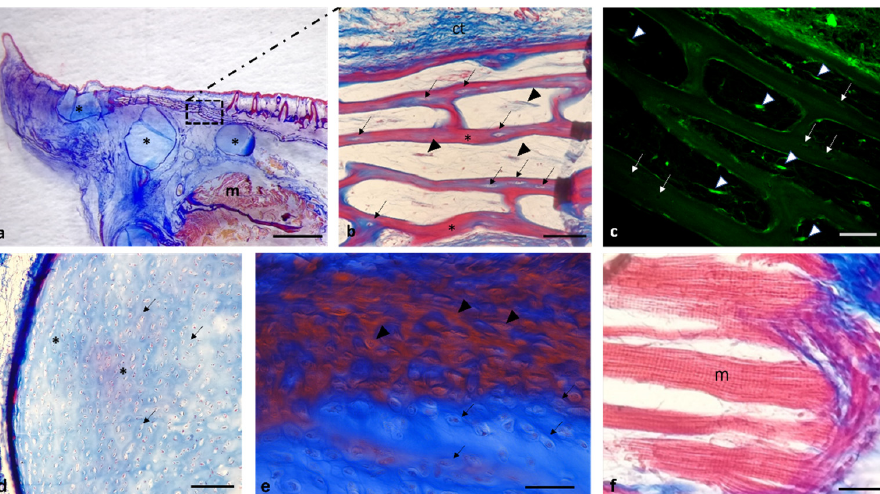
Figure 5. Masson Trichrome with Aniline Blue staining. ( a ) Stereomicrograph of a sagittal section of the tongue: tongue dorsal surface (arrows) covered by several papillae. ( b ) Light micrograph of tongue apex, corresponding to insert b: stratified epithelium with abundant caliciform cells (arrows), basal membrane (asterisk) connecting the epithelium and loose connective tissue (lct). ( c ) Mucosa of the tongue body raising in folds and showing taste buds (arrowhead), basal membrane (asterisk), dense connective tissue (dct) projecting at taste bud base; loose connective tissue (lct) in deeper layers. ( d ) Light micrograph of tongue root: villiform teeth in various eruption stages (asterisks), glandular extraepithelial and intramural bodies (arrowhead), excretory ducts (#), compact bone tissue (stars) replacing the pre-existing cartilaginous tissue (squares). ( e ) Scattered taste bud (dotted box), connective tissue (ct), teeth (asterisks), goblet cells (arrows). ( f ) Taste bud (arrowhead), dense connective tissue (dct), goblet cells (arrows). Scale bar: 500 µ m ( a ), 200 µ m ( d ), 100 µ m ( b , e ), 50 µ m ( c , f ).